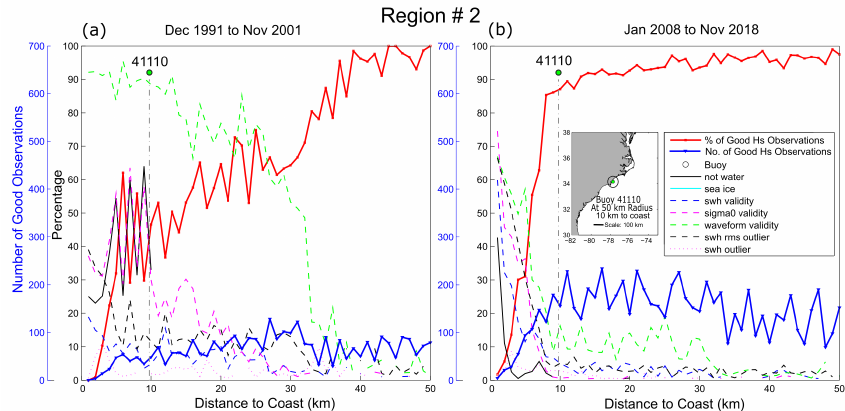
Figure 3. Total number of observations per 1 km bin, and proportion of data associated with good quality and rejection flags, as a function of distance to the coast, for region #2 on the east U.S. coast. The ( a ) first 10 years and ( b ) last 10 years of the Sea State CCI L2P satellite record are